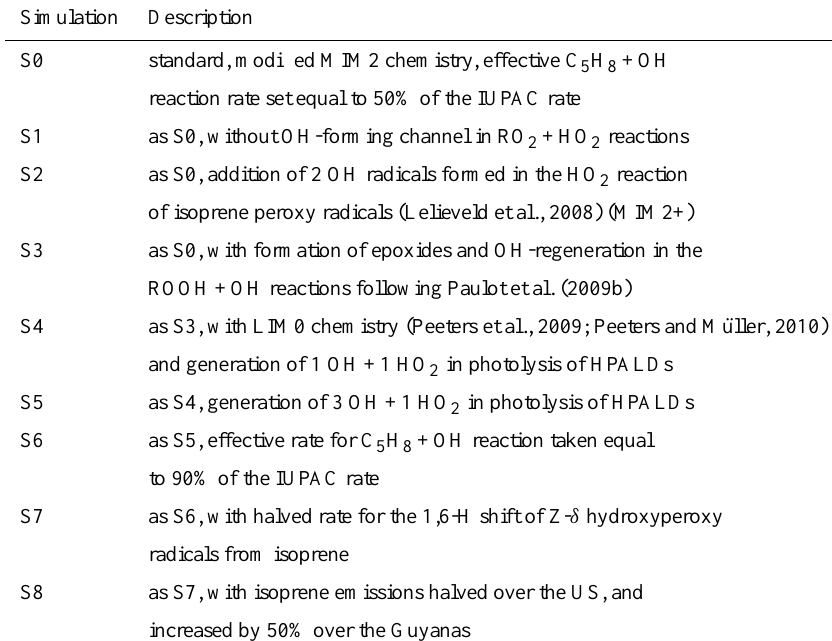
Table 2. Simulations performed using the IMAGESv2 global